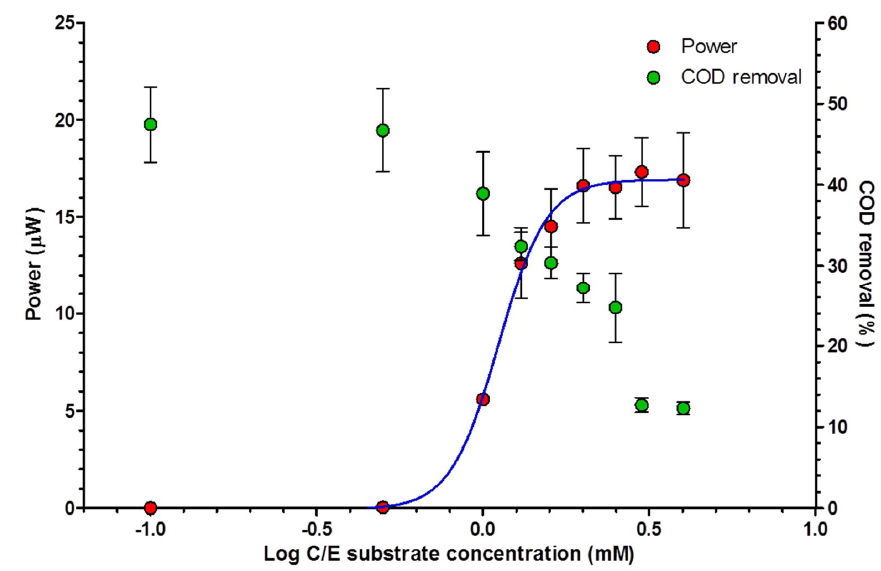
Figure 6 . Power generation and COD reduction response to substrate concentration at high dilution rate ( D = 10.2 h −1 ).